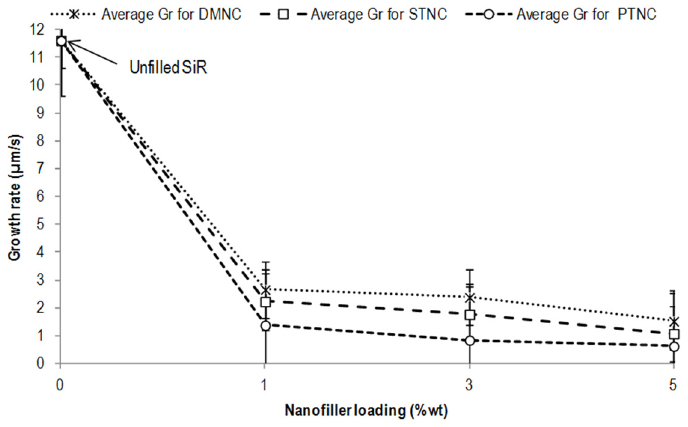
Figure 8. Growth rates for DMNC, STNC, and PTNC.